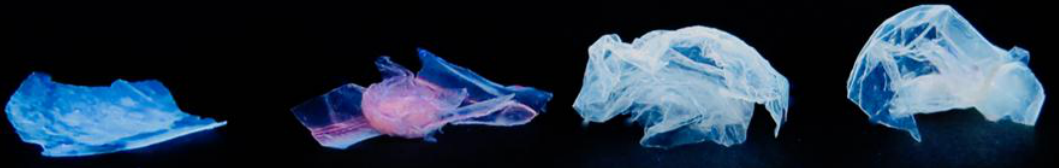
Figure 2. Emission spectra in the solid state for (a) P2 , (b) P3 , (c) CF , (d) P4-CF , (e) P3-CF and (f) P2-CF .